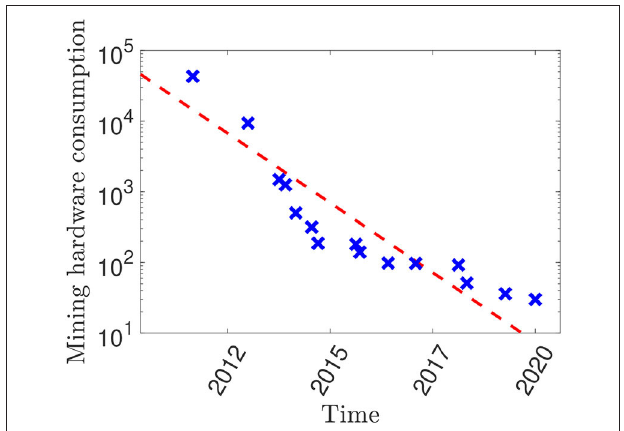
FIGURE 1 | Estimate of the lower bound for the energy consumption of the most efficient Bitcoin mining hardware, measured in J/Th.